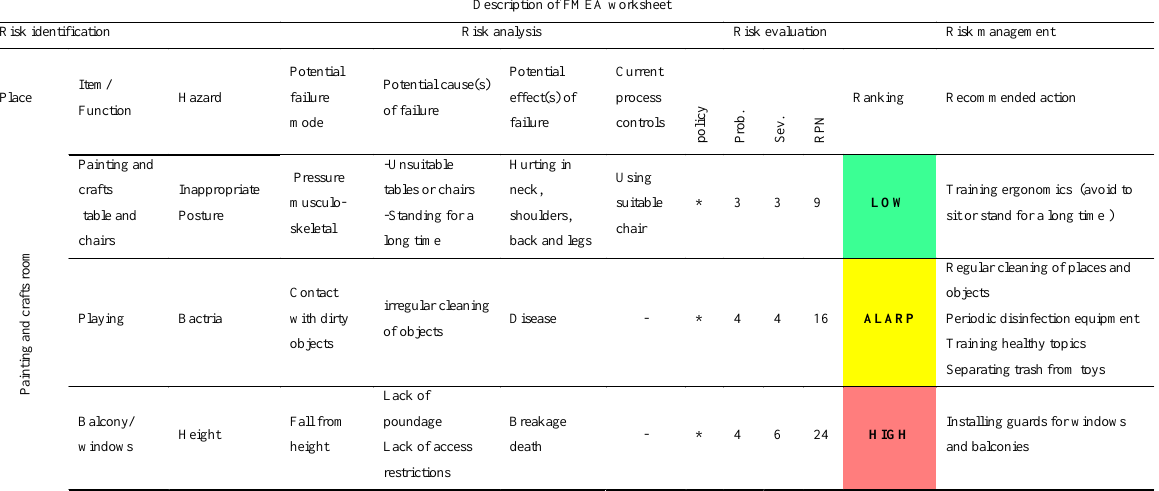
Table 3: An example of FMEA worksheet (a section of painting and crafts room) Description of FMEA